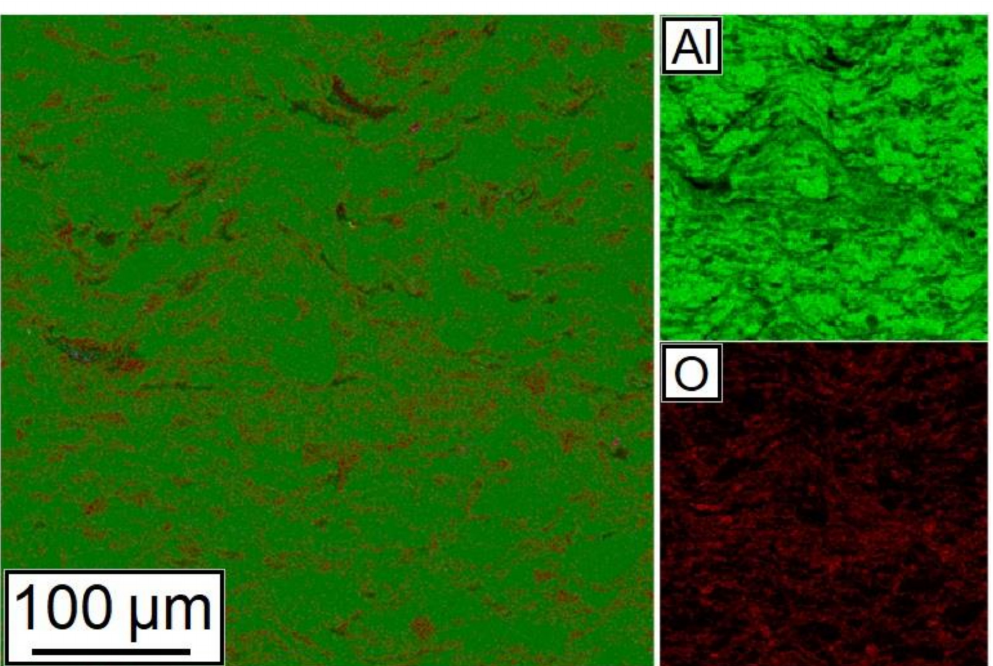
Figure 9. Distribution of chemical elements in the cross-section of the 28.5% Al + 70% Al 2 O 3 + 1.5% CNF sample.